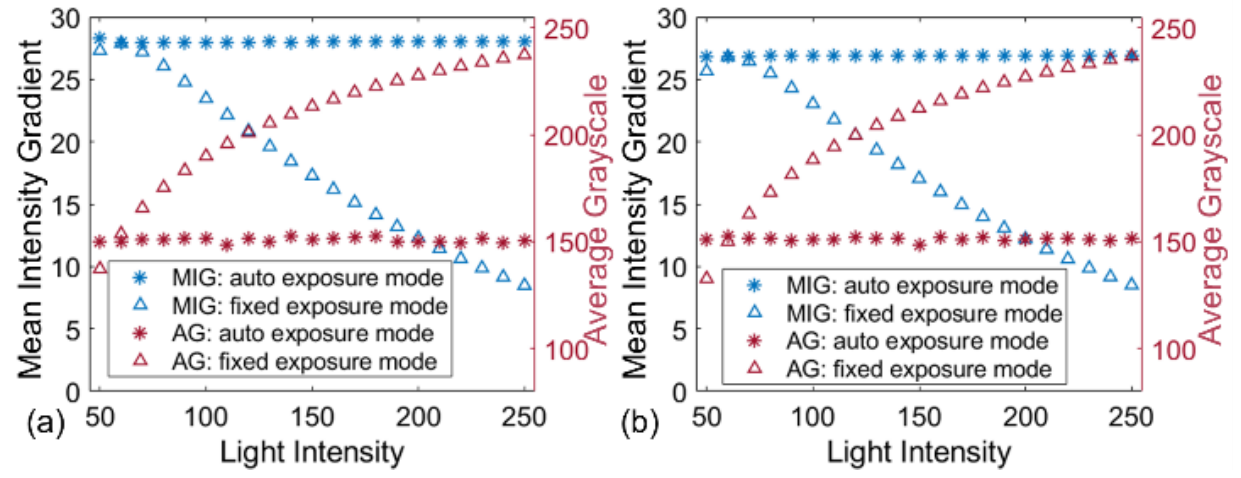
Figure 6. The calculated parameters (MIG and AG values) of the images captured with auto and fixed exposure modes by ( a ) left camera and ( b ) right camera.